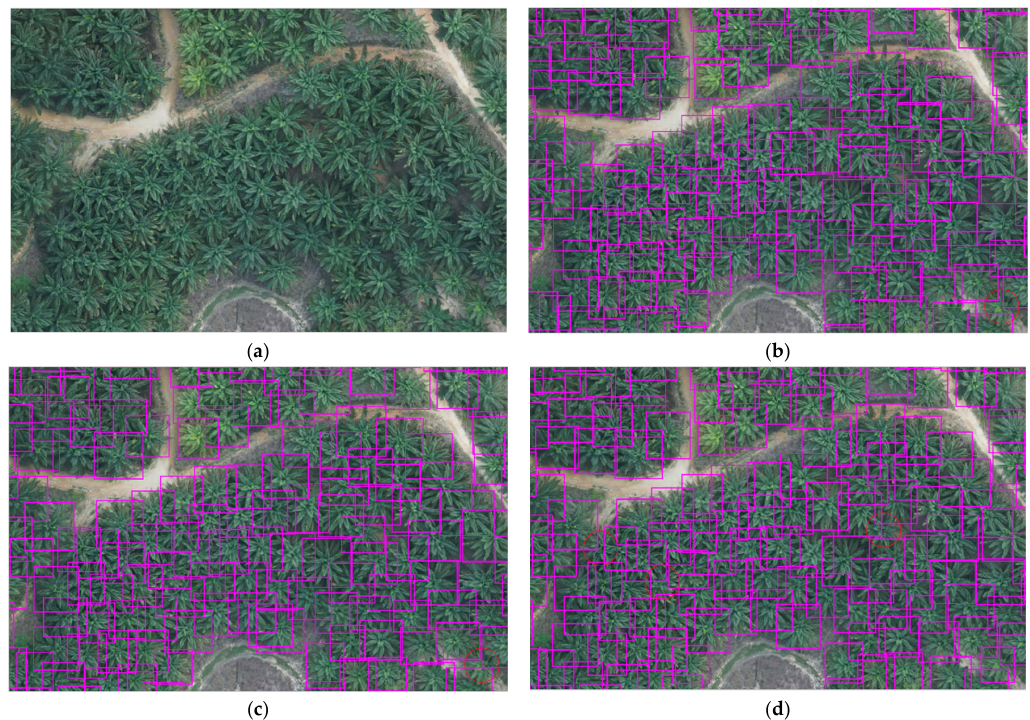
Figure 19. This weakness occurs because, at the time of labeling the oil palm class dataset, the majority of oil palm tree conditions are healthy/normal, while, for the unhealthy oil Figure 16. The overlapping canopy condition of the oil palm trees: ( a ) Original image; ( b ) YOLOv3 detection; ( c ) YOLOv4 detection; ( d ) YOLOv5m detection. palm tree conditions and the oil palm trees intersecting with other vegetations (disguised), the labeling samples are few, so it is quite difficult to detect when testing the data. There were several shortcomings of the models during testing. It was quite challeng- ing to detect oil palm trees with unhealthy oil palm conditions (stressed growth or nutri- ent deficiency), as shown by the red circles in Figures 17 and 18. In addition, the models had difficulty detecting (red circles) or incorrectly detecting (blue circles) for the condition where the oil palm trees intersect with other vegetations, so it is disguised, as shown in